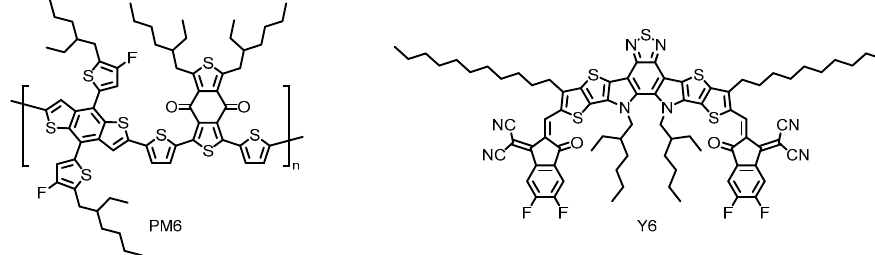
Figure 4. Chemical structures of polymeric donor PM6 and small molecular acceptor Y6 employed in the state-of-the-art organic solar cells (OSC). Adapted from ref [32].